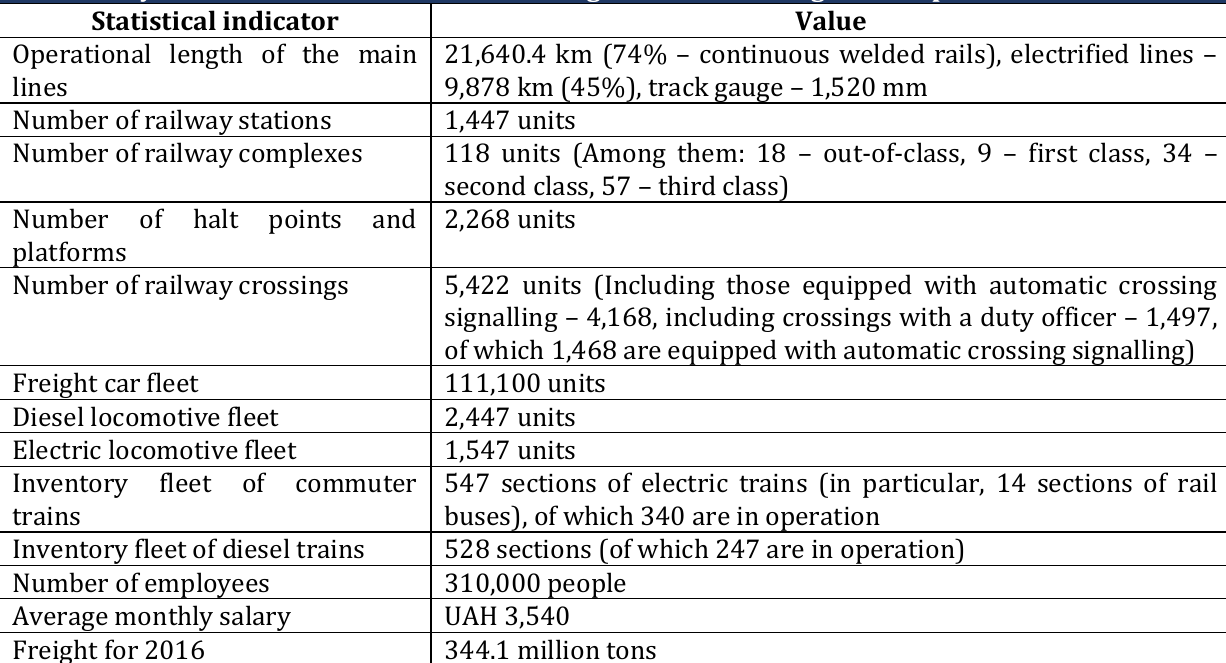
Table 1. Key Performance Indicators for the Segment of Rail Freight Transportation Statistical indicator Value Operational length of the